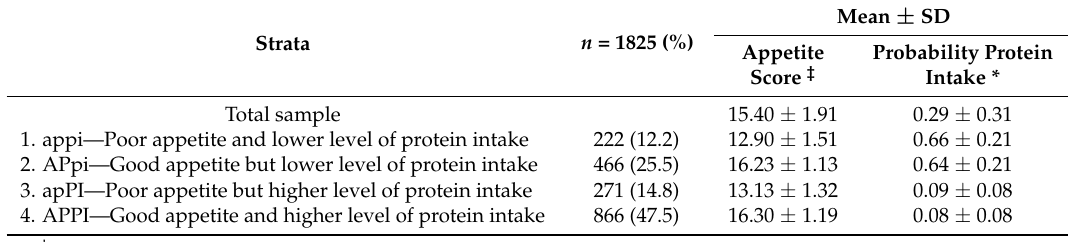
Table 1. Size and mean scores of the appetite and protein intake strata in 1825 adults aged 65 years and older from five European